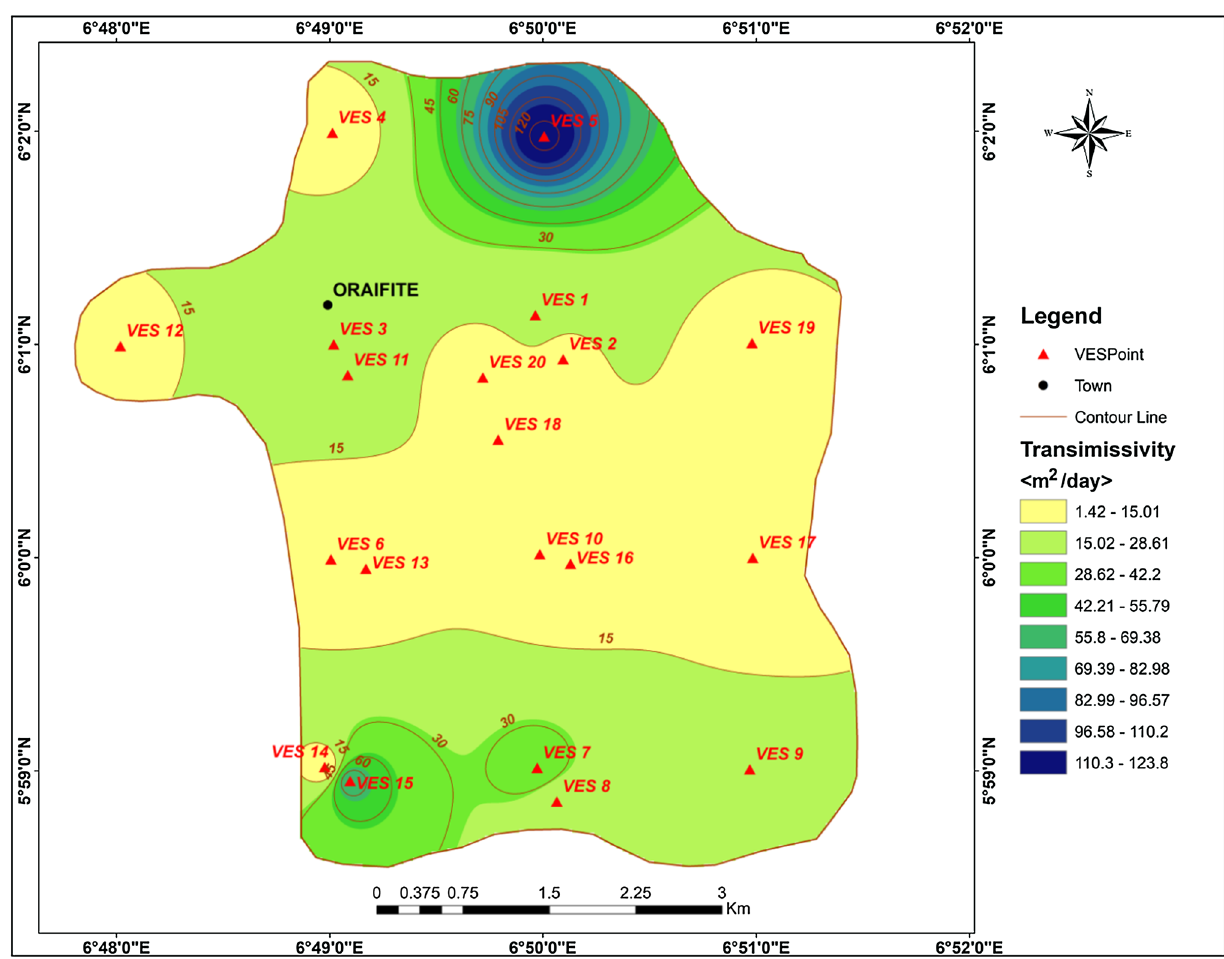
Fig. 8 Contour map showing the variation of transmissivity in the study